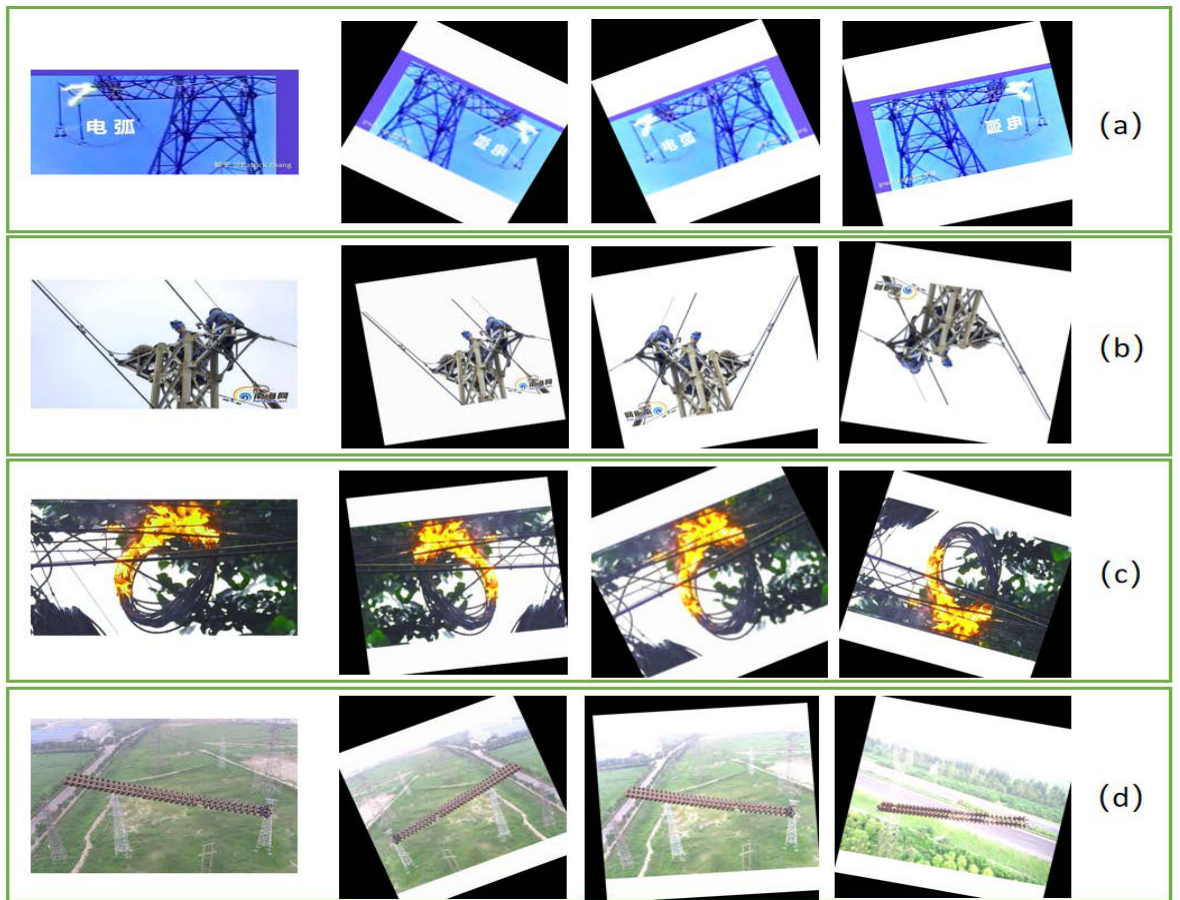
Figure 7. Partial image display of TLDPSD-2022 dataset; ( a ) arc phenomenon, ( b ) bird’s nest, ( c ) fire, ( d ) insulator breakage defect.